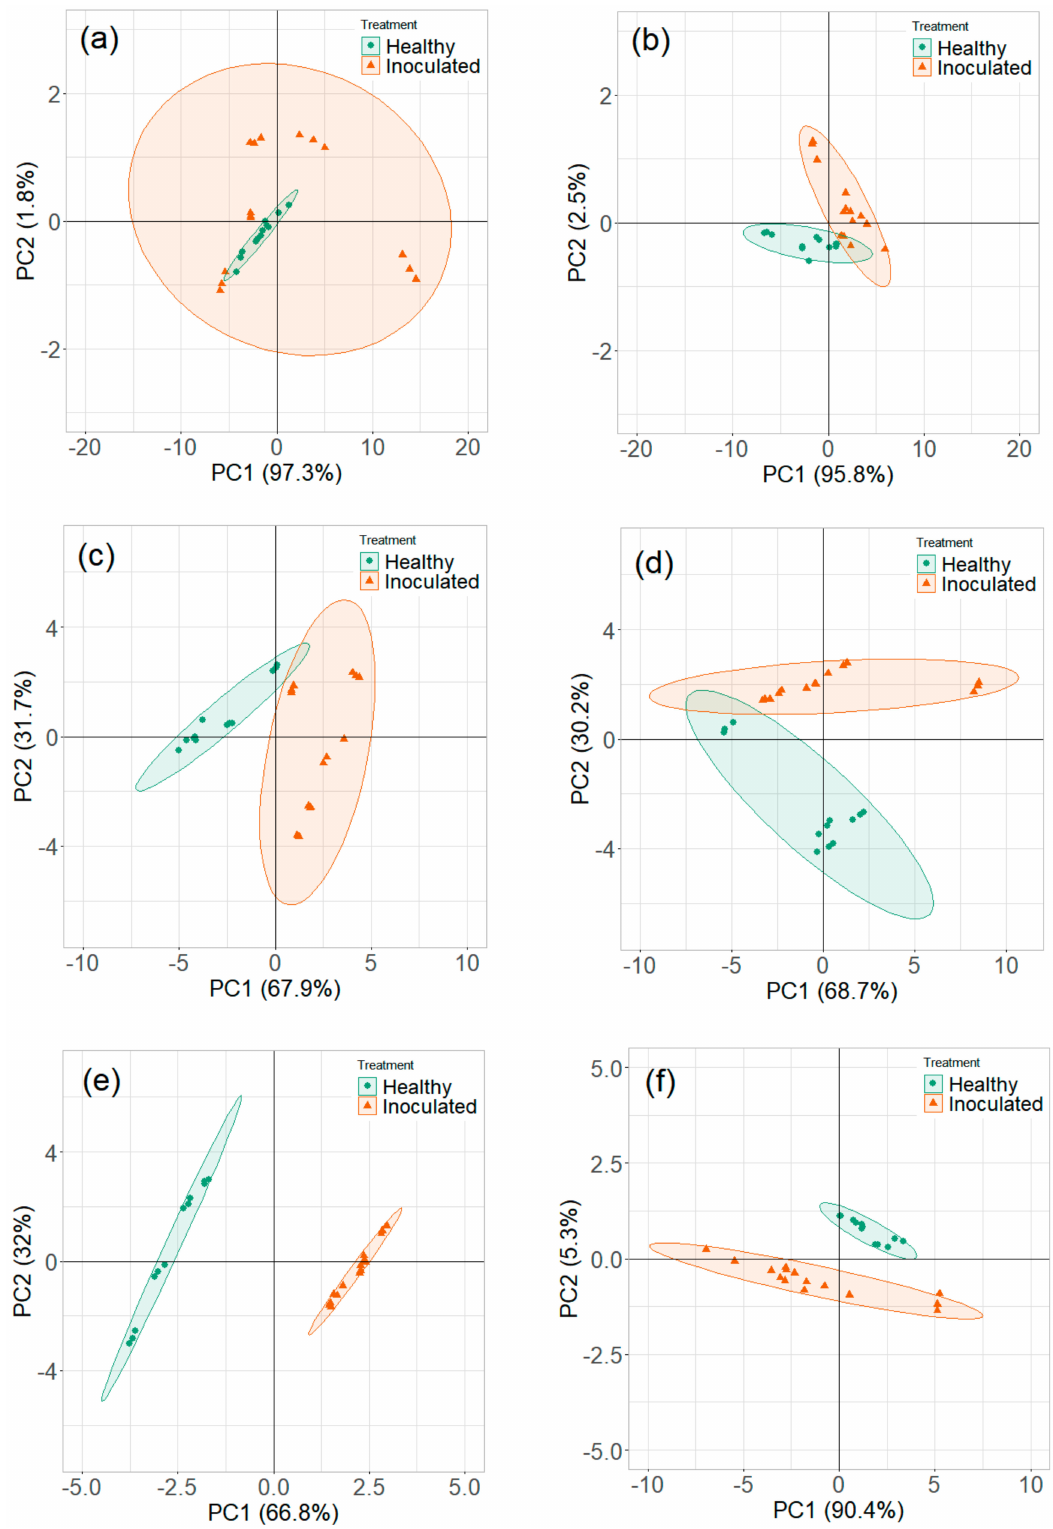
Figure 9. Principal component analysis plots for ion current of Ranger Russet tuber samples stored at room temperature (25 ◦ C, experiment-1) on ( a ) 0th, ( b ) 1st, ( c ) 3rd, ( d ) 5th, ( e ) 7th, and ( f ) 14th days after